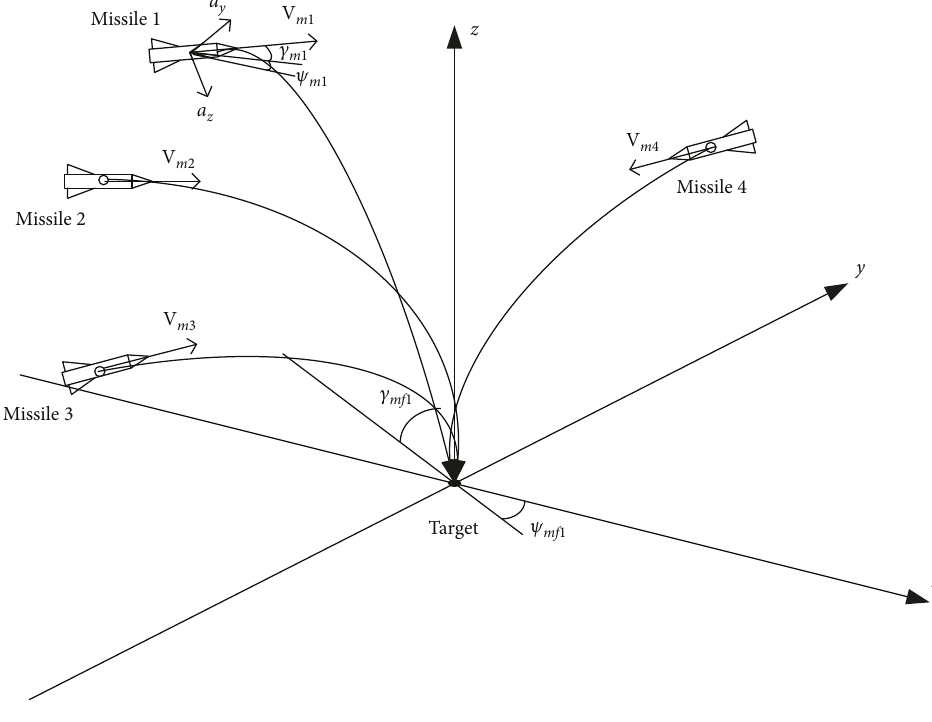
Figure 1: 3D engagement geometry of cooperation